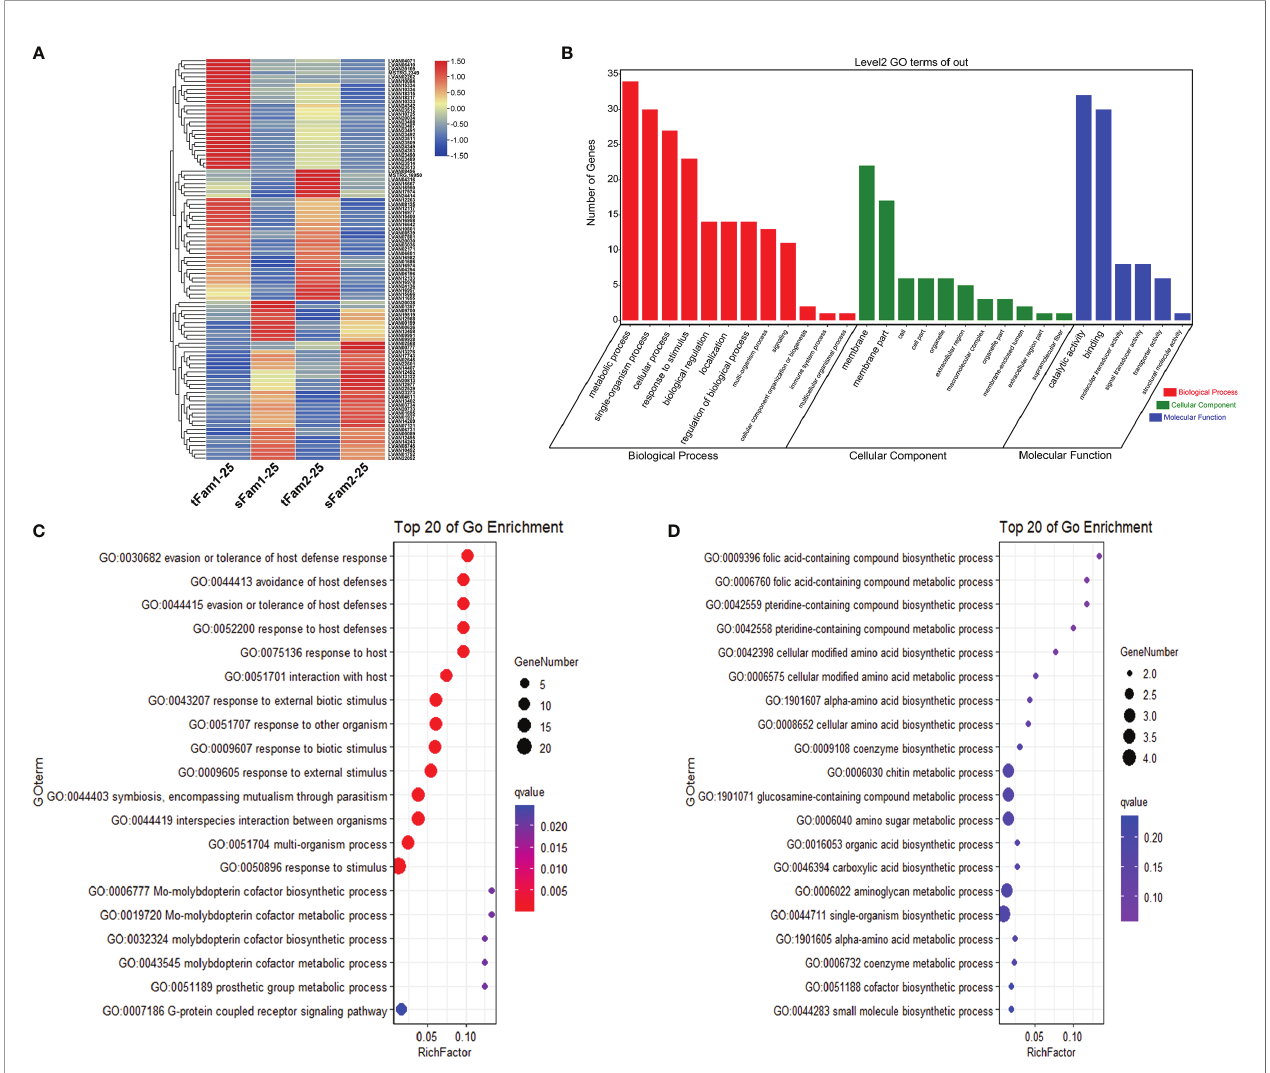
FIGURE 1 | DEGs between high-salinity tolerant families and susceptible families under normal salinity condition in Litopenaeus vannamei . (A) Gene expression heatmap of DEGs. (B) GO enrichment analysis of DEGs. (C) Top 20 GO terms enriched in the categories of biological process for DEGs upregulated in tolerant families, the point color shows different Q values as indicated on the right, and red color represents the signi fi cantly enriched GO term (Q < 0.05). (D) Top 20 GO terms enriched in the categories of Biological process for DEGs upregulated in susceptible families; the point color shows different Q values as indicated on the right. DEGs, differentially expressed genes; GO, Gene